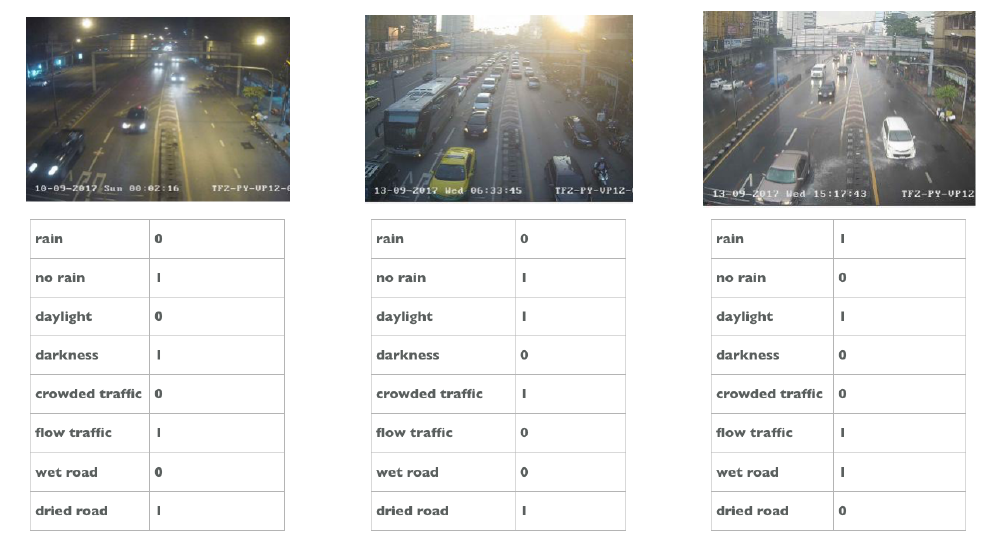
Figure 3. Example of multiple events in images represented as one-hot labels.